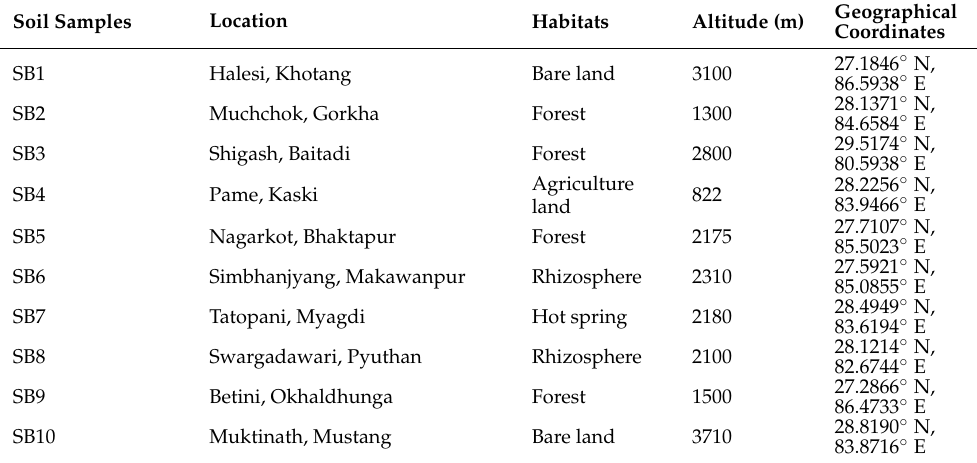
Table 1. Description of the soil samples collected from untouched habitats in